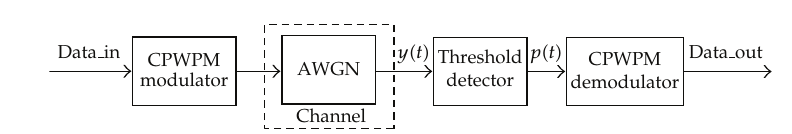
Figure 4: Simplified model of a CPWPM system.